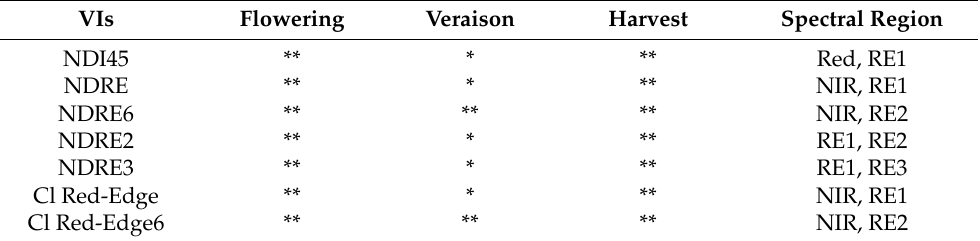
Table 6. Cont. VIs Flowering Veraison Harvest Spectral Region